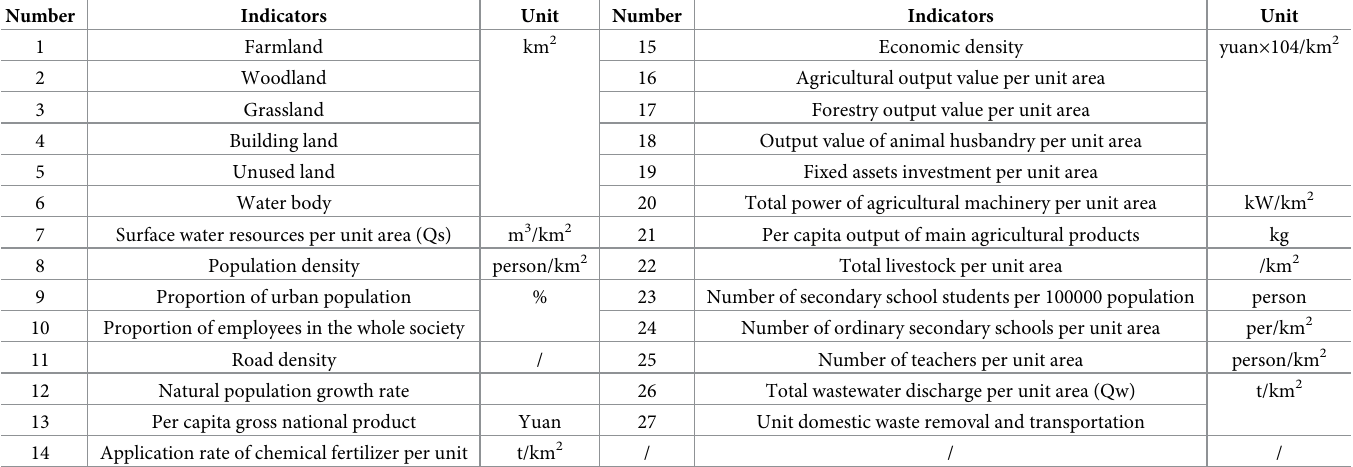
Table 2. Factors influencing the quality of provincial boundary water bodies.